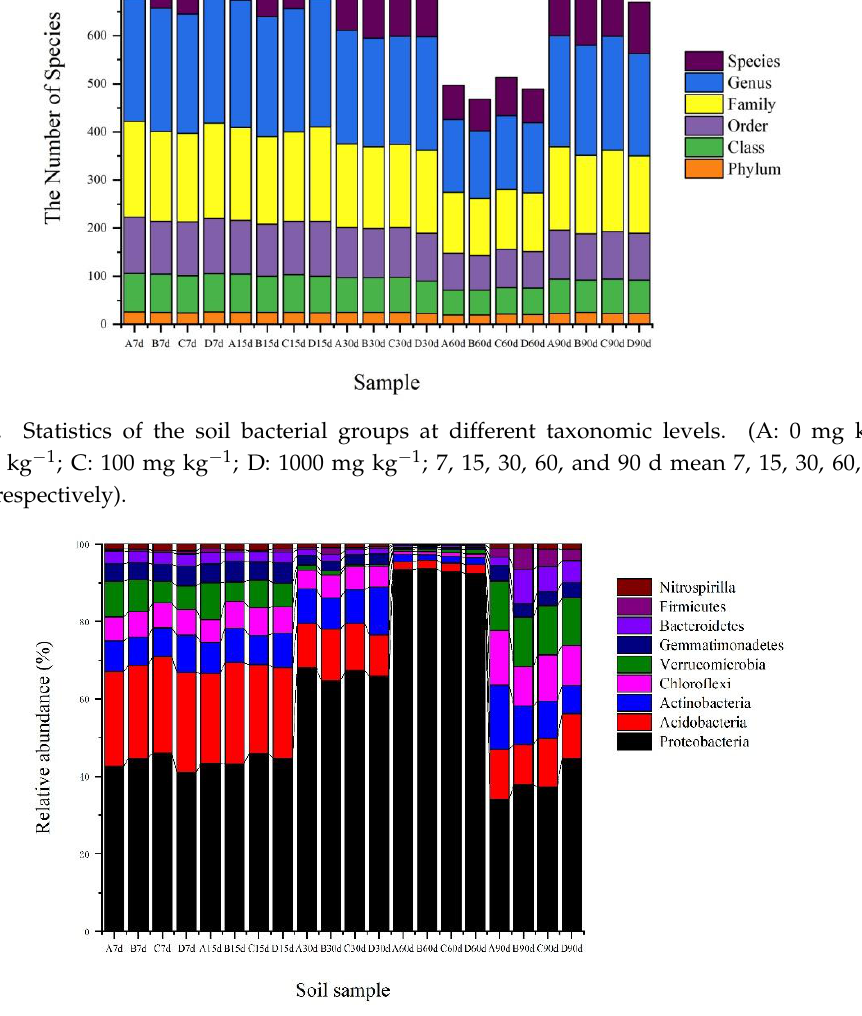
Figure 6. Bacterial compositions of the nine most abundant phyla in the soil samples treated with graphene (A: 0 mg kg −1 ; B: 10 mg kg −1 ; C: 100 mg kg −1 ; D: 1000 mg kg −1 ; 7, 15, 30, 60, and 90 d mean 7, 15, 30, 60, and 90 days, respectively).